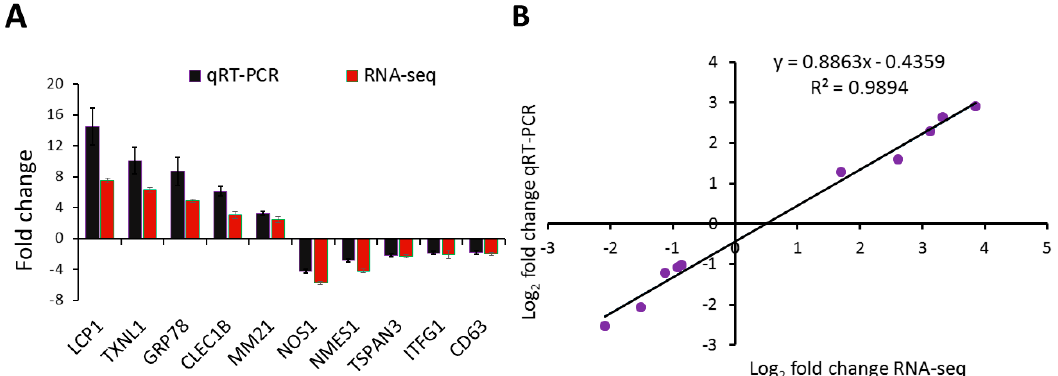
Figure 8 Figure 8. Validation of RNA-seq by qRT-PCR and linear regression plot between RNA-seq and qRT-PCR. ( A ) Five upregulated and five downregulated genes determined by di ff erential gene expression analysis of RNA-seq data were selected for qRT-PCR analysis. The gene expression values are represented as relative fold change (mean ± SEM) of infected zooids ( n = 6) compared to the uninfected control zooids group ( n = 6). ( B ) The log 2 fold change values for the RNA-seq and qRT-PCR are plotted along with the linear fit line showing a significant Pearson’s correlation coe ffi cient r (8) = 0.995, p < 0.00001 and a coe ffi cient of determination R 2 =